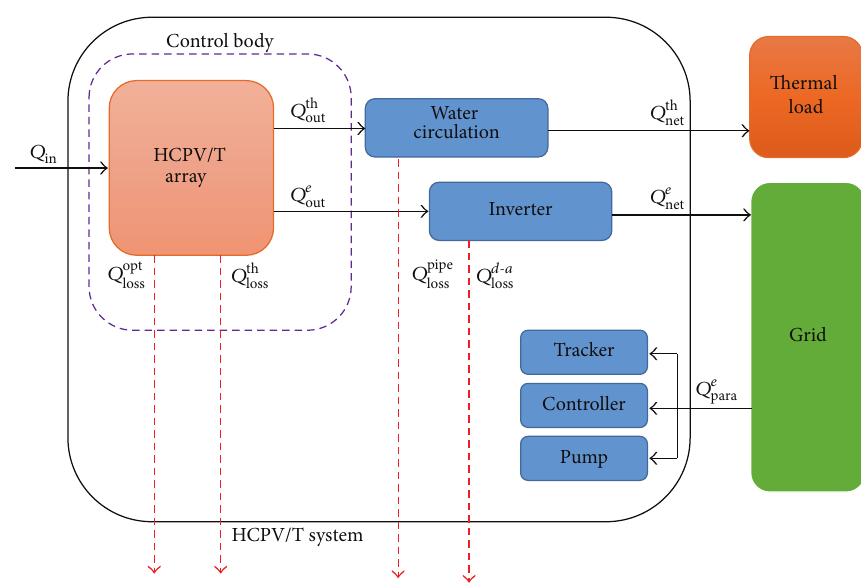
Figure 6: Schematic of the energy balance of a HCPV/T system.